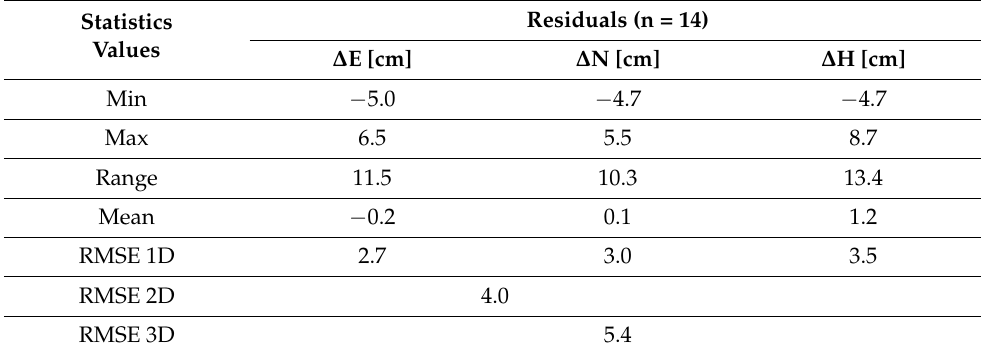
Table 8. Statistics of residuals between the determined and referent displacement vectors values and RMSE of determining displacements with the proposed data processing method.